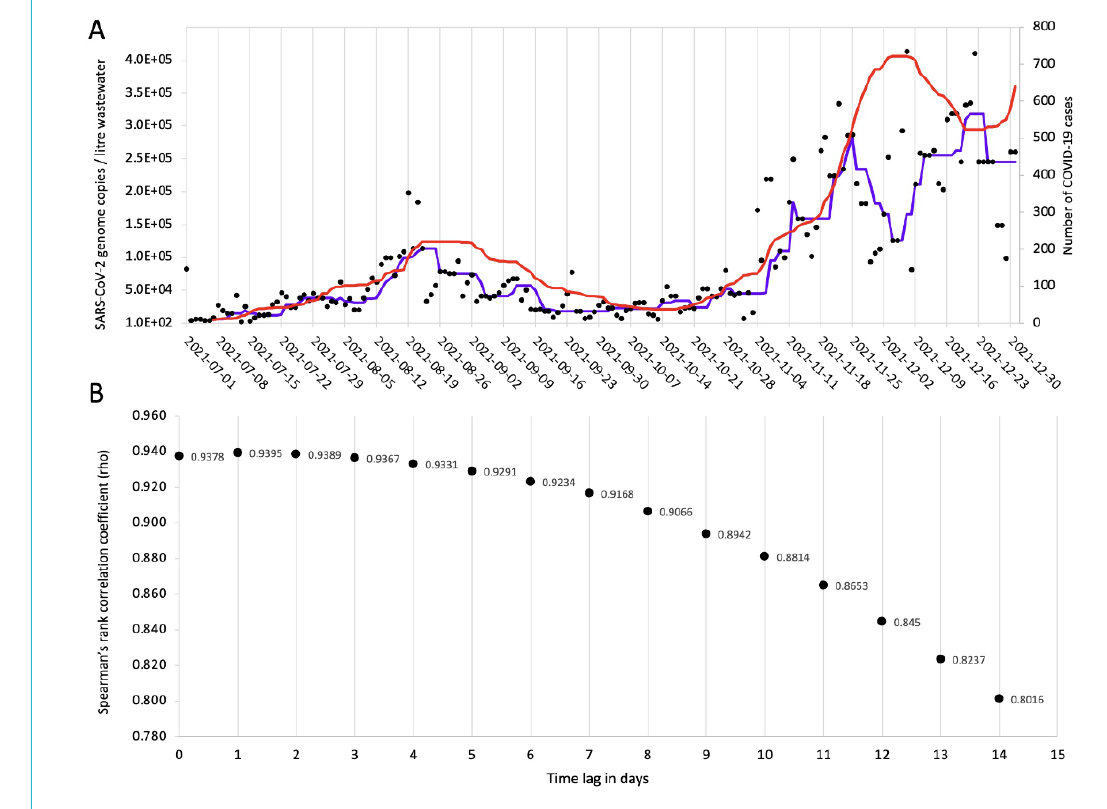
Figure 1: Detection of SARS-CoV-2 RNA in wastewater in relation to COVID-19 case numbers in the catchment area of the city of Basel dur- ing the indicated period A) The number of SARS-CoV-2 genome copies of each composite wastewater sample (dots) and their seven-day me- dian (blue line) are shown per litre of wastewater (non-normalised). The number of newly reported COVID-19 cases is represented by the me- dian seven-day incidence (red line). B) The seven-day median number of SARS-CoV-2 genome copies/litre wastewater was correlated with the time-lagged (zero to 14 days; x-axis) median seven-day incidence of SARS-CoV-2 cases, and Spearman’s rank coefficients values are